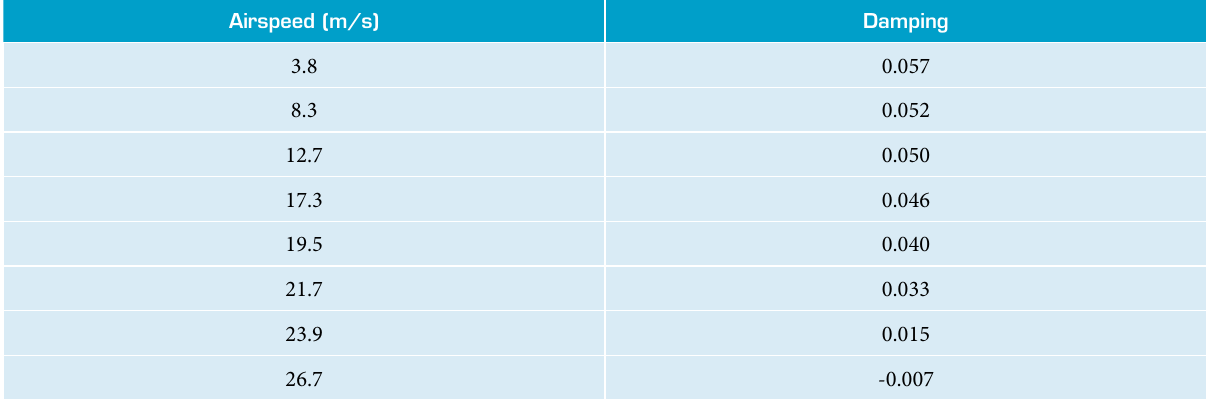
Table 3. Speeds tested and its damping